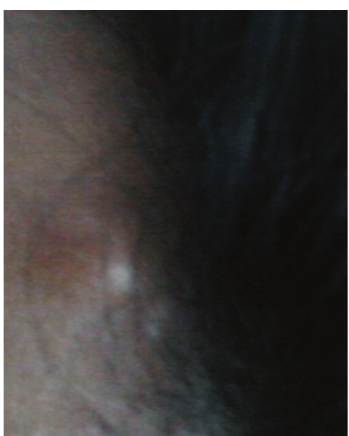
Figure 1: Papulonodular lesion on the scalp.